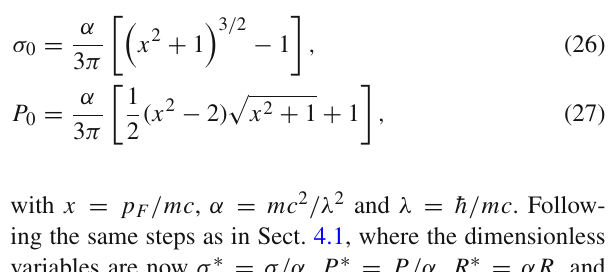
Fig. 1 The figure shows the m ∗ as well as the critical values of Ω 2 that follow from dynamical stability (see Eq. 22), and those that follow from the EOS, in red and blue, respectively